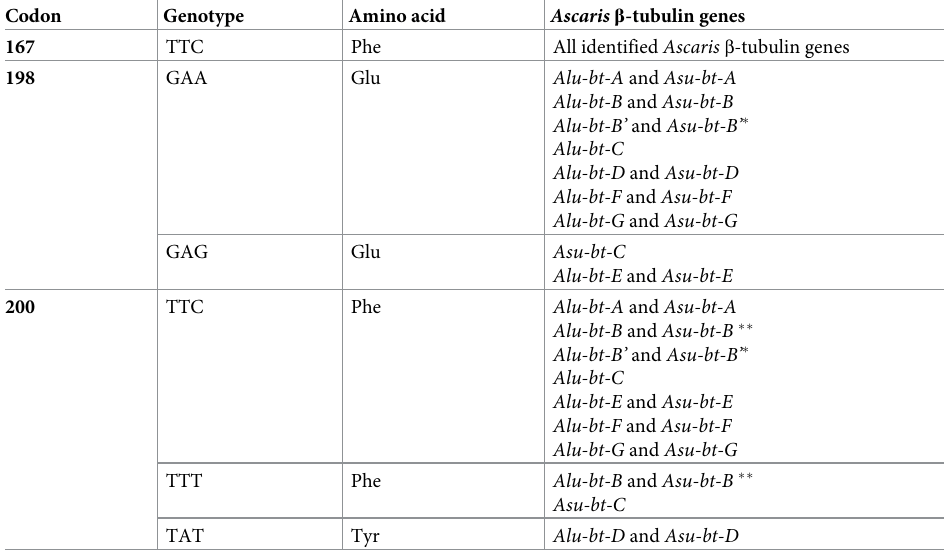
Table 3. Genotype of codons 167, 198 and 200 in the identified Ascaris β -tubulin genes.